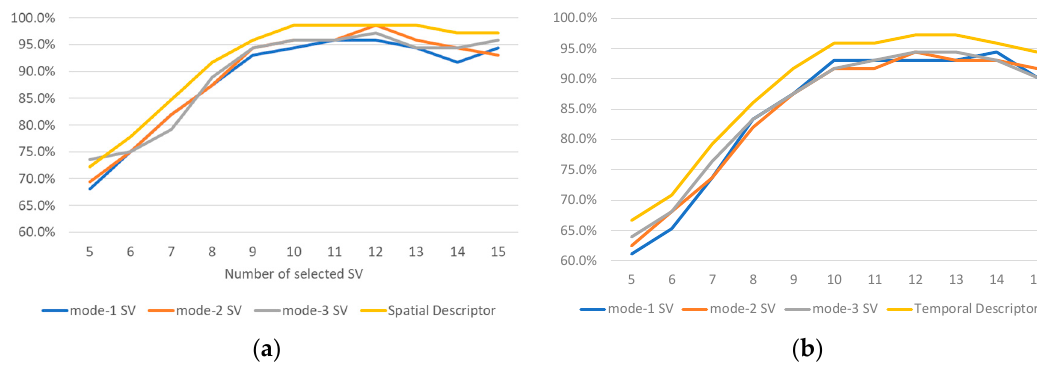
Figure 4. Action recognition rates of ( a ) Spatial Descriptor and ( b ) Temporal Descriptor using the first five to fifteen SVs and applying the proposed method to the CERTH dataset.